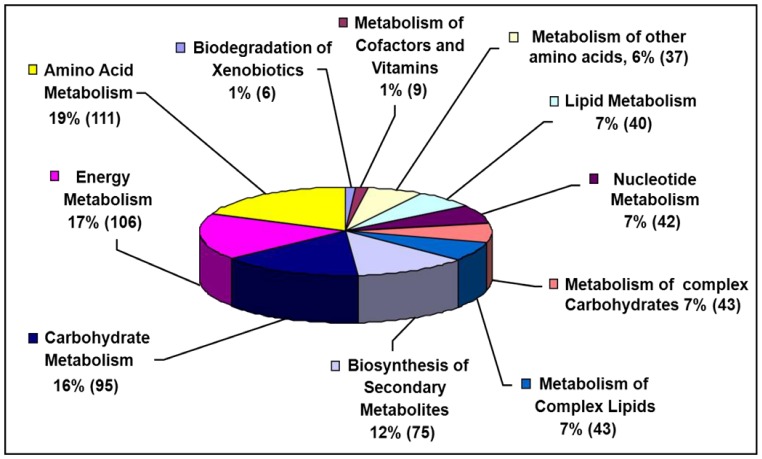
cDNA library of petunia cuttings.Classification of putative proteins into different categories of metabolism during various developmental stages of adventitious root formation in petunia cuttings. Numbers of putative proteins in different categories of the KEGG superpathway are shown in parentheses. Total protein number was 607 (out of 4,700 EST‘s).